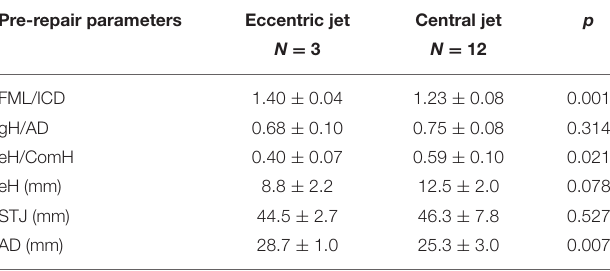
TABLE 4 | Pre-repair leaflet-root parameters stratified by AR jet. Pre-repair parameters